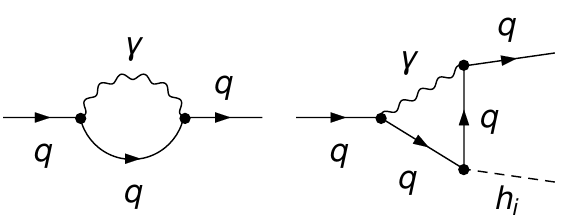
Figure 6 . The QED subset. Left: The quark self-energy containing an internal photon line. Right: The vertex correction with an internal photon